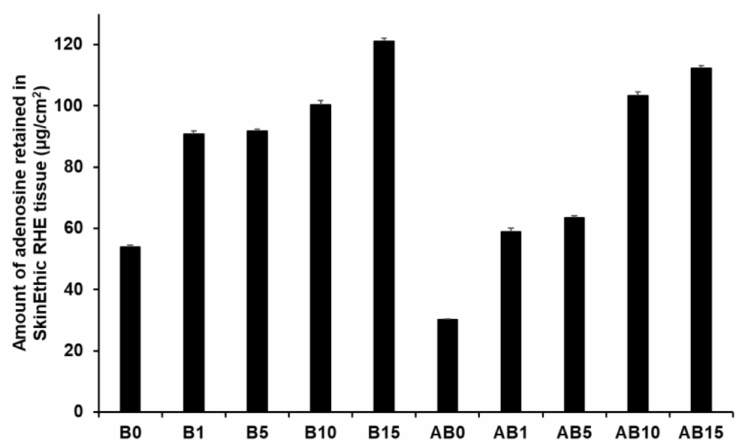
Figure 15. Retention studies for the synthesized elastic artificial skin with/without SLNs in SkinEthic RHE model after permeation studies. Results are expressed as means ± standard deviations of three independent experiments ( n = 3). B0: Non-SLN B formulation; B1: B formulation with 1% SLNs; B5: B formulation with 5% SLNs; B10: B formulation with 10% SLNs; B15: B formulation with 15% SLNs; AB0: Non-SLN artificial skin; AB1: Artificial skin with 1% SLNs; AB5: Artificial skin with 5%